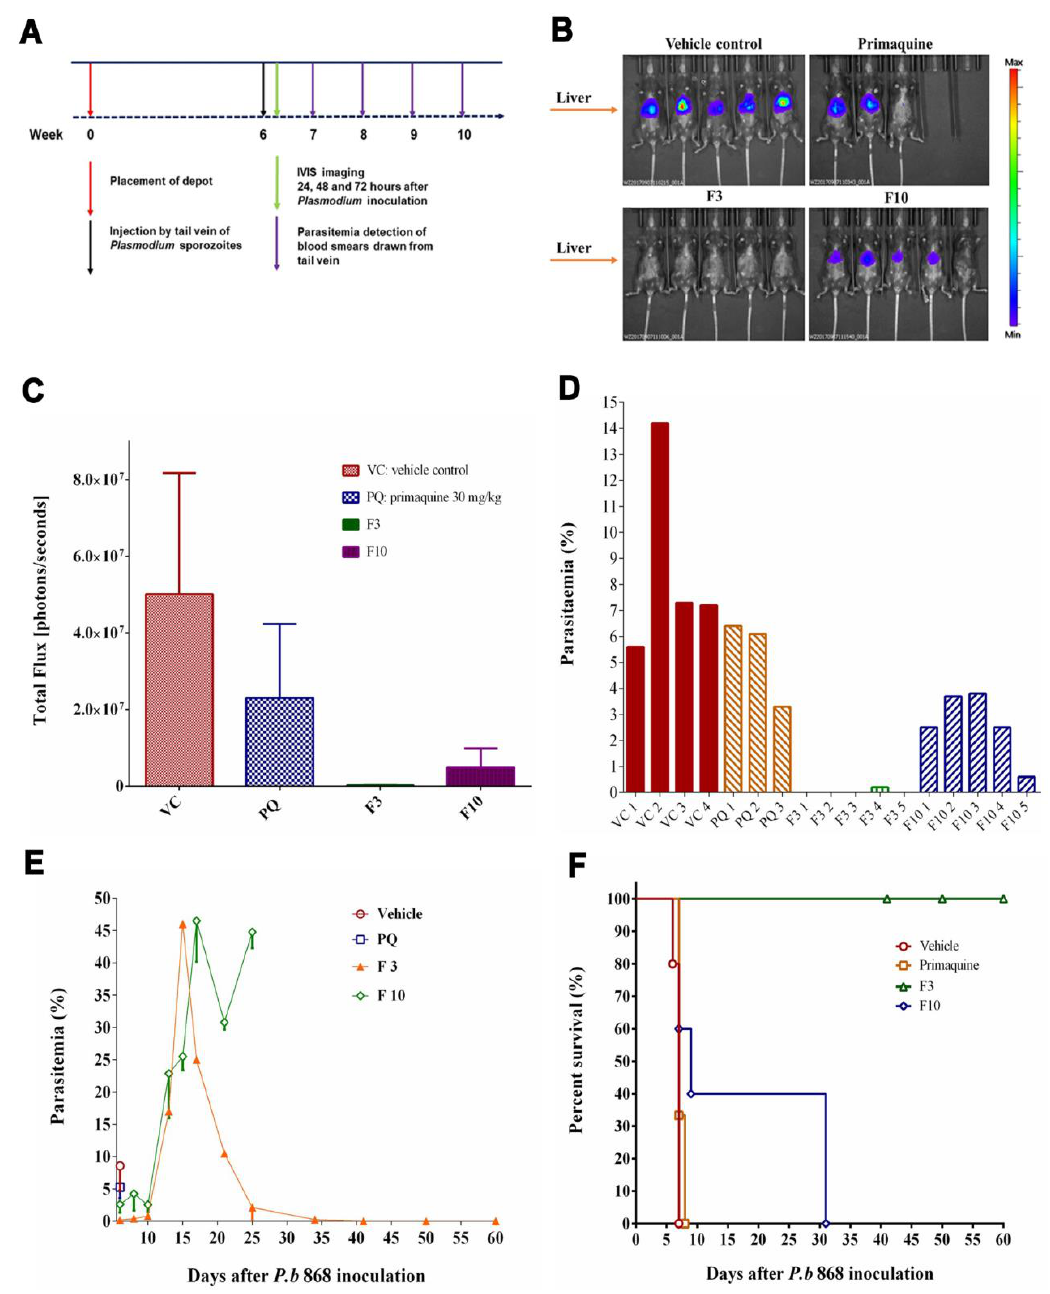
Figure 2. Evaluation of SRFD (F3) in malaria prophylaxis. ( A ) A schematic depiction of animal experimental design for the data shown in ( B – F ). ( B ) F3 at a dose of DQ 200 mg/kg, vehicle control of F3 (no DQ), F10 dissolved in NMP, and primaquine phosphate (PQ) at a dose of 30 mg/kg dissolved in saline, were given to mice by IM. Six weeks later, mice were inoculated with SPZ of Plasmodium berghei ANKA 868 expressing firefly luciferase via the tail vein. Images were acquired by using In Vivo Image Systems (IVIS) 46 h after the inoculation. ( C ) Counts presented as the flux of photons, corresponding to images in ( B ) from IVIS detection. ( D ) Parasitemia detection 6 days after Plasmodium berghei SPZ inoculation. ( E ) Parasitemia was detected periodically over 60 days after SPZ inoculation. The lines were interrupted at the time when animals were seriously ill and euthanized. Note that one animal in the F3 group was infected but recovered, parasitemia level peaked at day fifteen, then down to zero on day 35, and no recrudescence occurred. ( F ) The percentage of animals that survived 60 days after SPZ